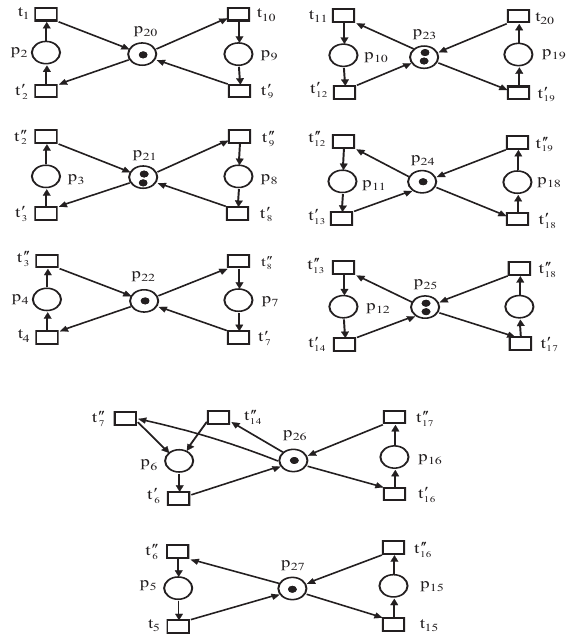
Figure 13. Decentralized subnets of Petri net model for